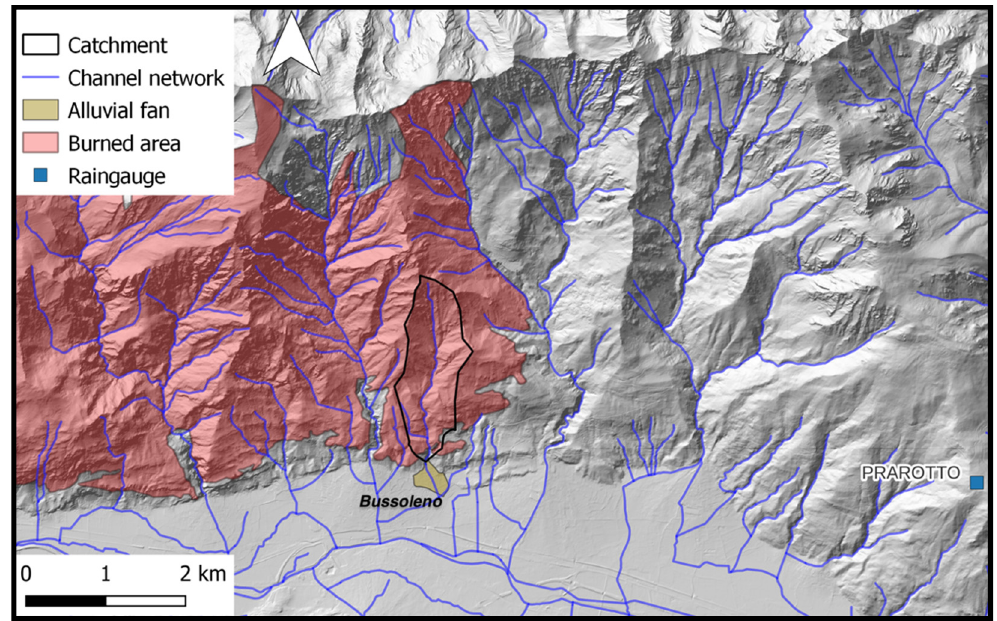
Figure 6. Map shows the delimitation of wildfire involving the Rio delle Foglie catchment and near- est raingauge (Prarotto weather station). weather